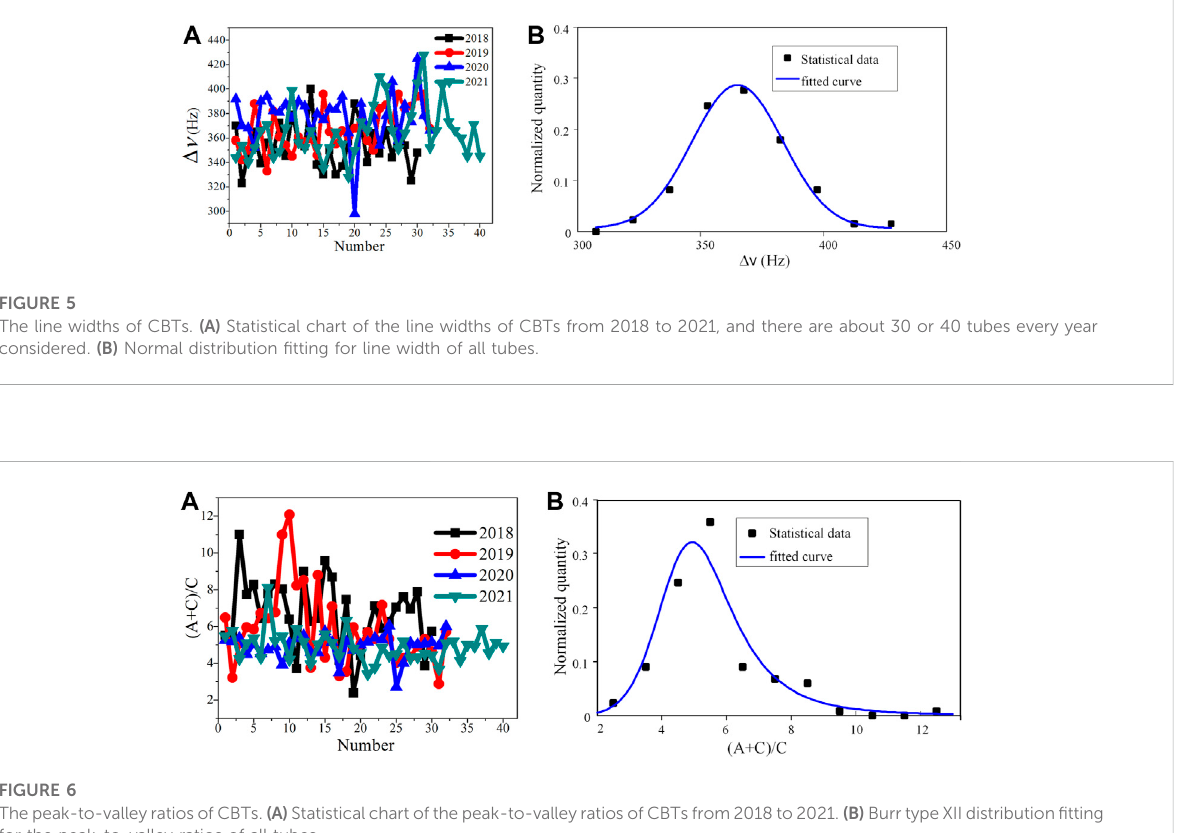
Thepeak-to-valleyratiosofCBTs. (A) Statisticalchartofthepeak-to-valleyratiosofCBTsfrom2018to2021. (B) BurrtypeXIIdistribution fi tting for the peak-to-valley ratios of all